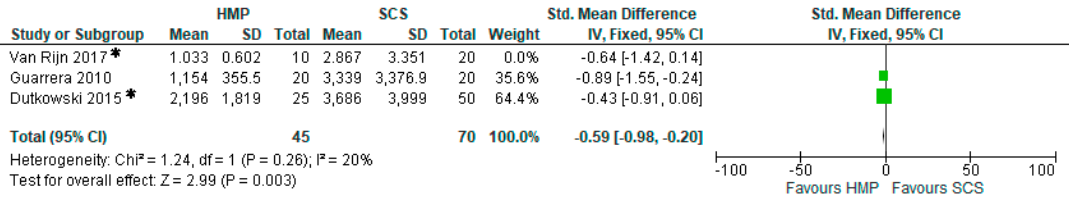
Figure 17. One week post transplantation peak serum total bilirubin in studies comparing HMP to SCS. In papers marked with “ * ”, mean and standard deviation were calculated using the method described by Wan 2014 [5].